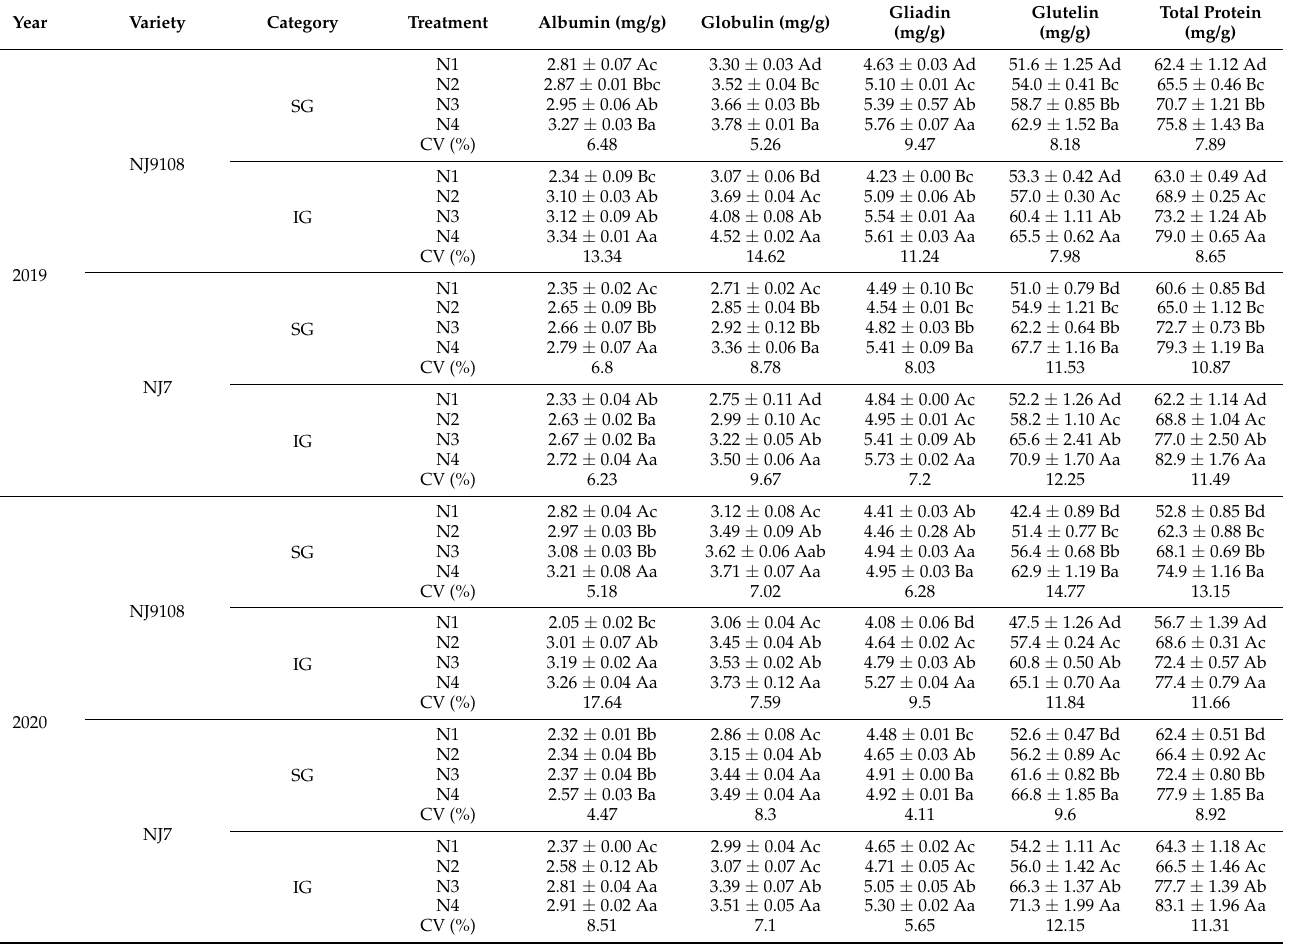
Table 5. Effects of nitrogen fertilizer levels on nutritional quality of superior and inferior grains in rice in 2019 and